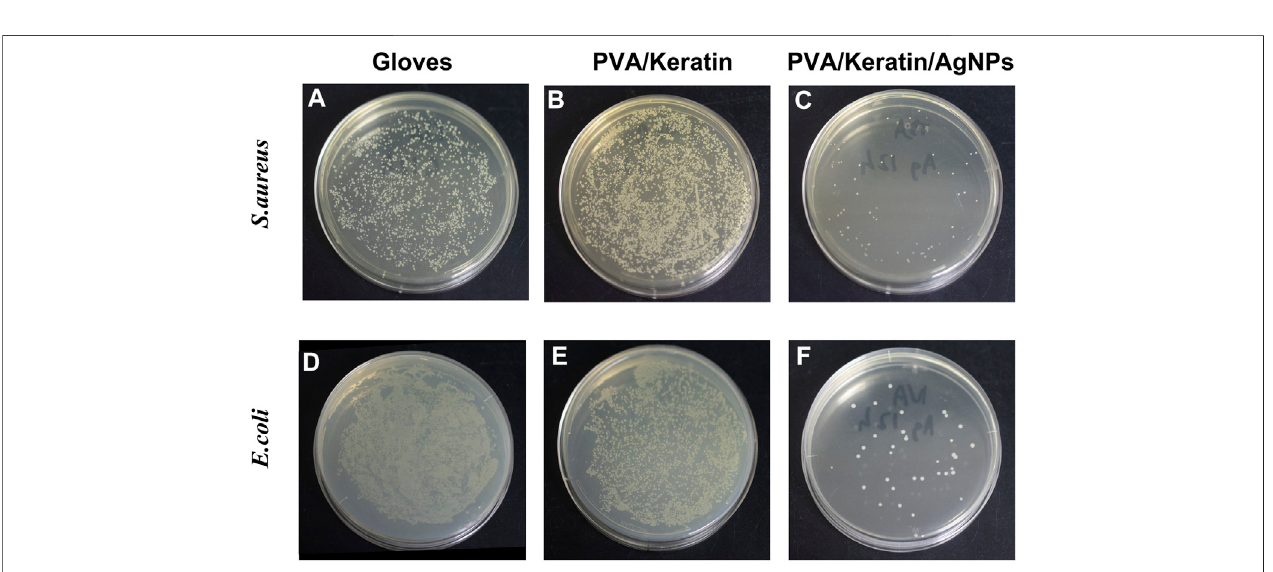
FIGURE 8 | Photographs of bacterial colonies formed by (A – C) S. aureus and (D – F) E. coli of different materials after 24 h of culturing.